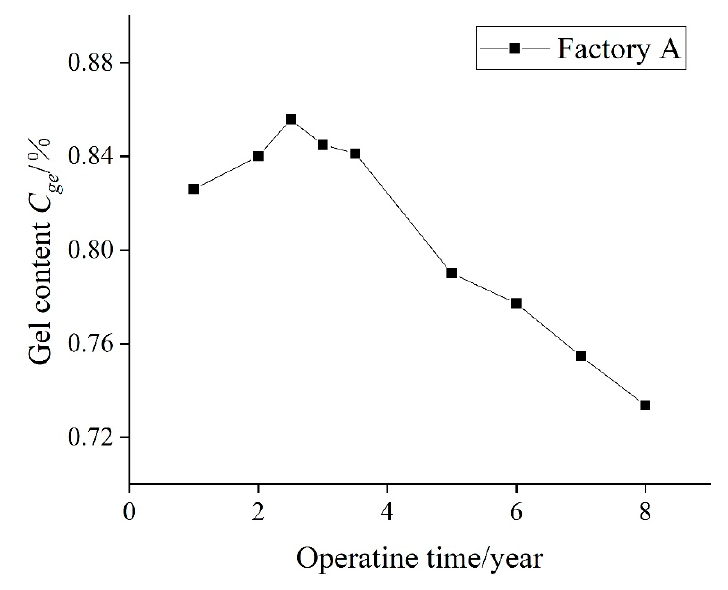
Figure 1. Test results of gel content test.